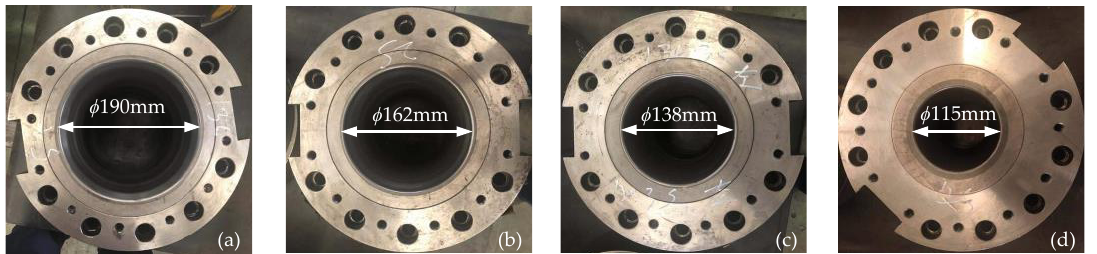
Figure 12. Reducing dies. ( a ) First pass; ( b ) second pass; ( c ) third pass; ( d ) fourth pass.